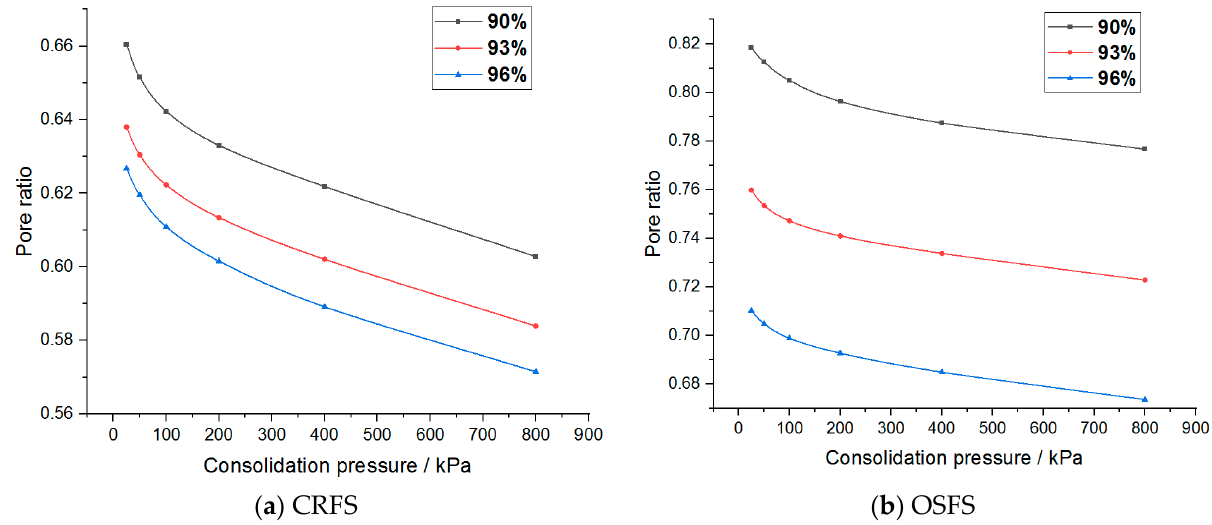
Figure 11. Pore ratio–stress curve of modified soil with different compaction degrees.